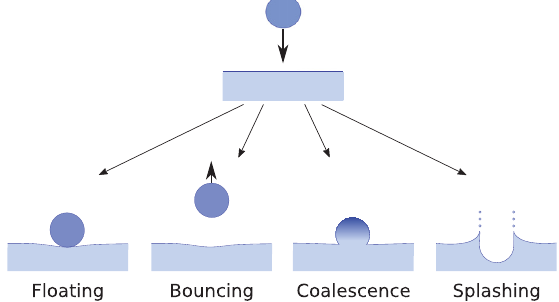
Fig. 1. Impact of a drop on a liquid surface, inspired from Rein [1].